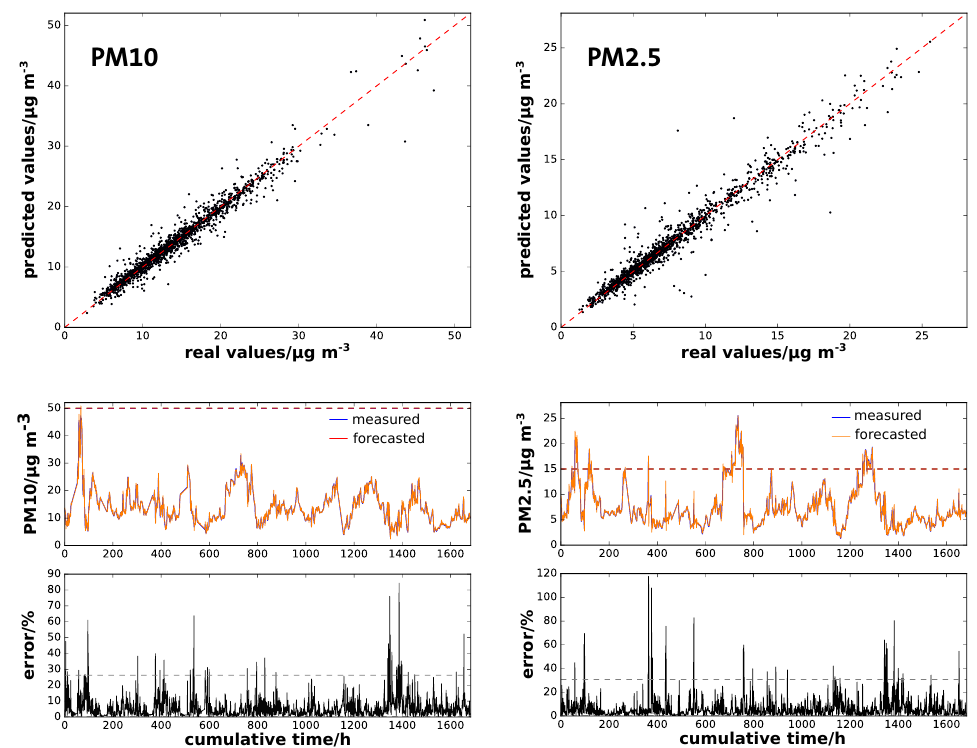
Figure 2. Dispersion, concentration, and error over time dependencies for the third test iteration of forecasting without seasonality decomposition. Dispersion plots: R 2 = 0.933 for PM10 and R 2 = 0.920 for